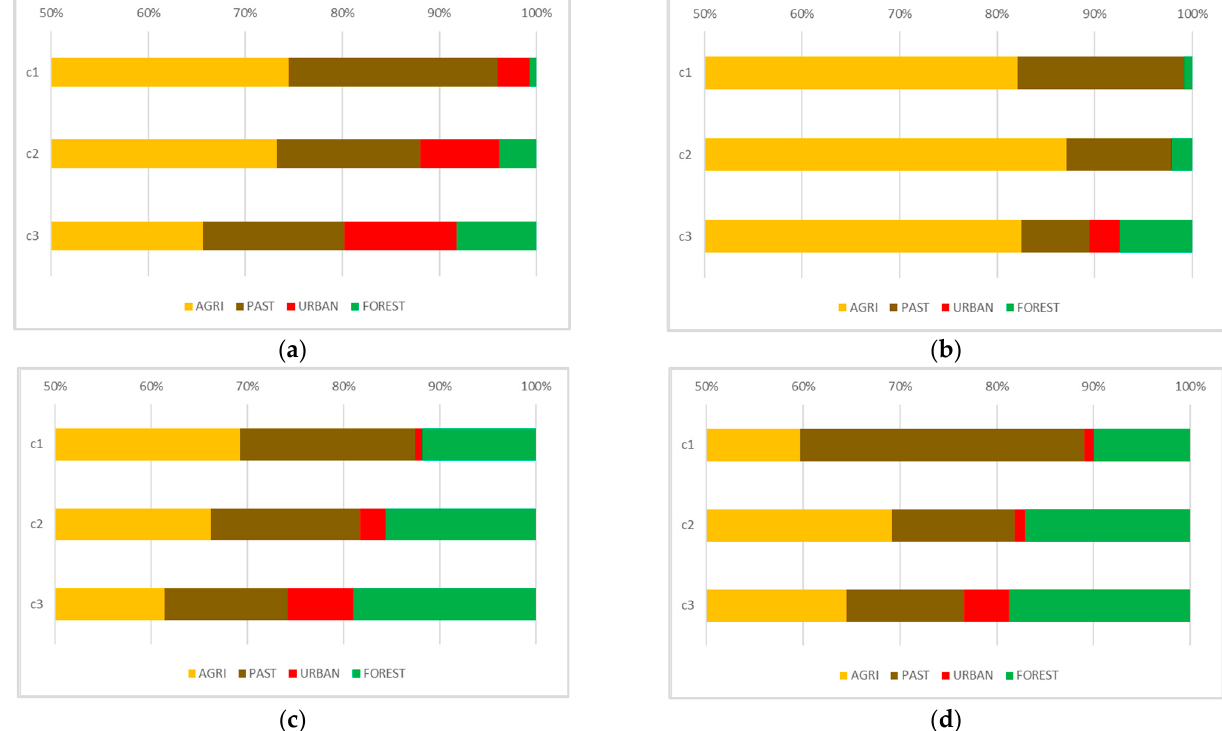
Figure 9. Land cover dynamics in the four upstream areas for ( a ) Sugar Creek, ( b ) Flatrock, ( c ) Columbus, and ( d ) Seymour outlet.